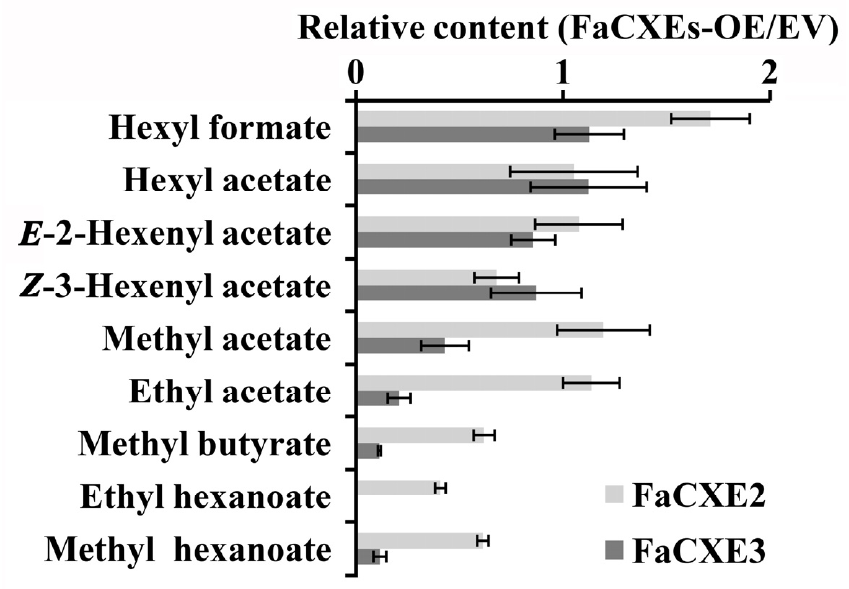
Figure 7. Relative content analysis of volatile esters in transiently overexpressing FaCXEs strawberry fruits and empty vector (EV). In all biological replicates, at least 10 fruits were used for used for each construct. Data are presented as mean ± SE obtained from three biological replicates.